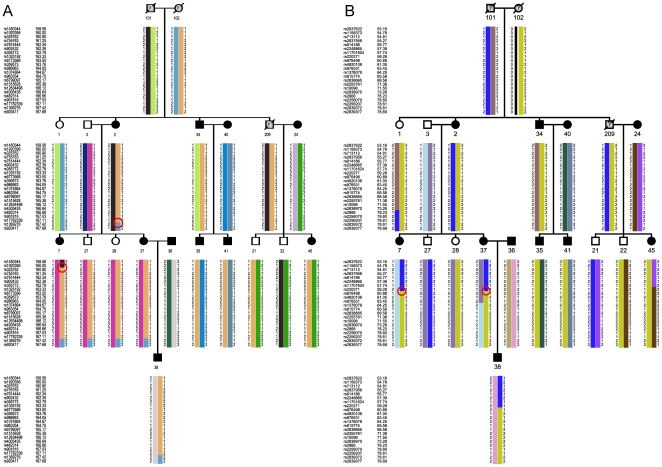
The most likely haplotypes of the FH pedigree on chromsomes 3q25-26 (A) and 21q22 (B).The black symbols indicated the affected individuals. The red circles indicated critical recombinations. Marker names and their positions (cM) are listed on the left side.